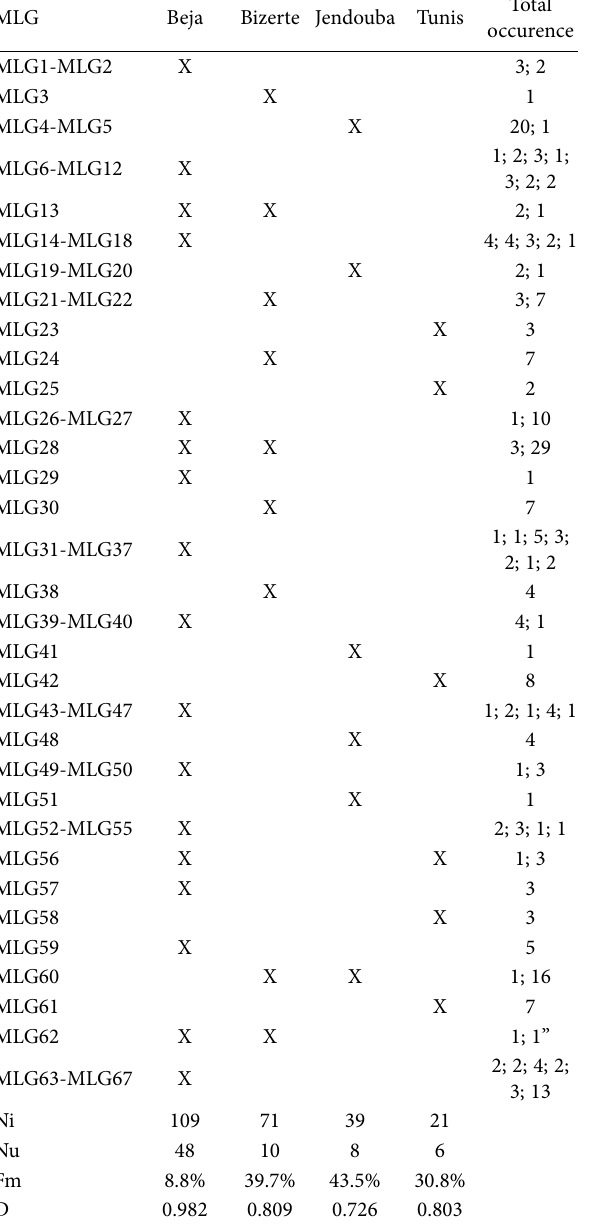
Table 6. Genetic diversity, multilocus gametic disequilibrium, and test for random mating within Ascochyta fabae populations from Tunisia sampled during the 2012 cropping